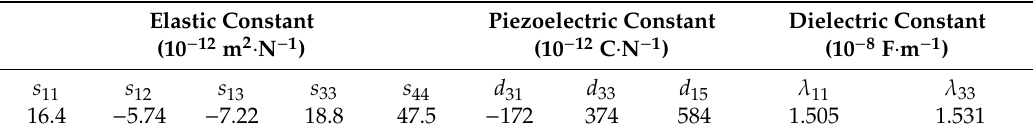
Table 7. Materials parameters of PZT-5 [33].